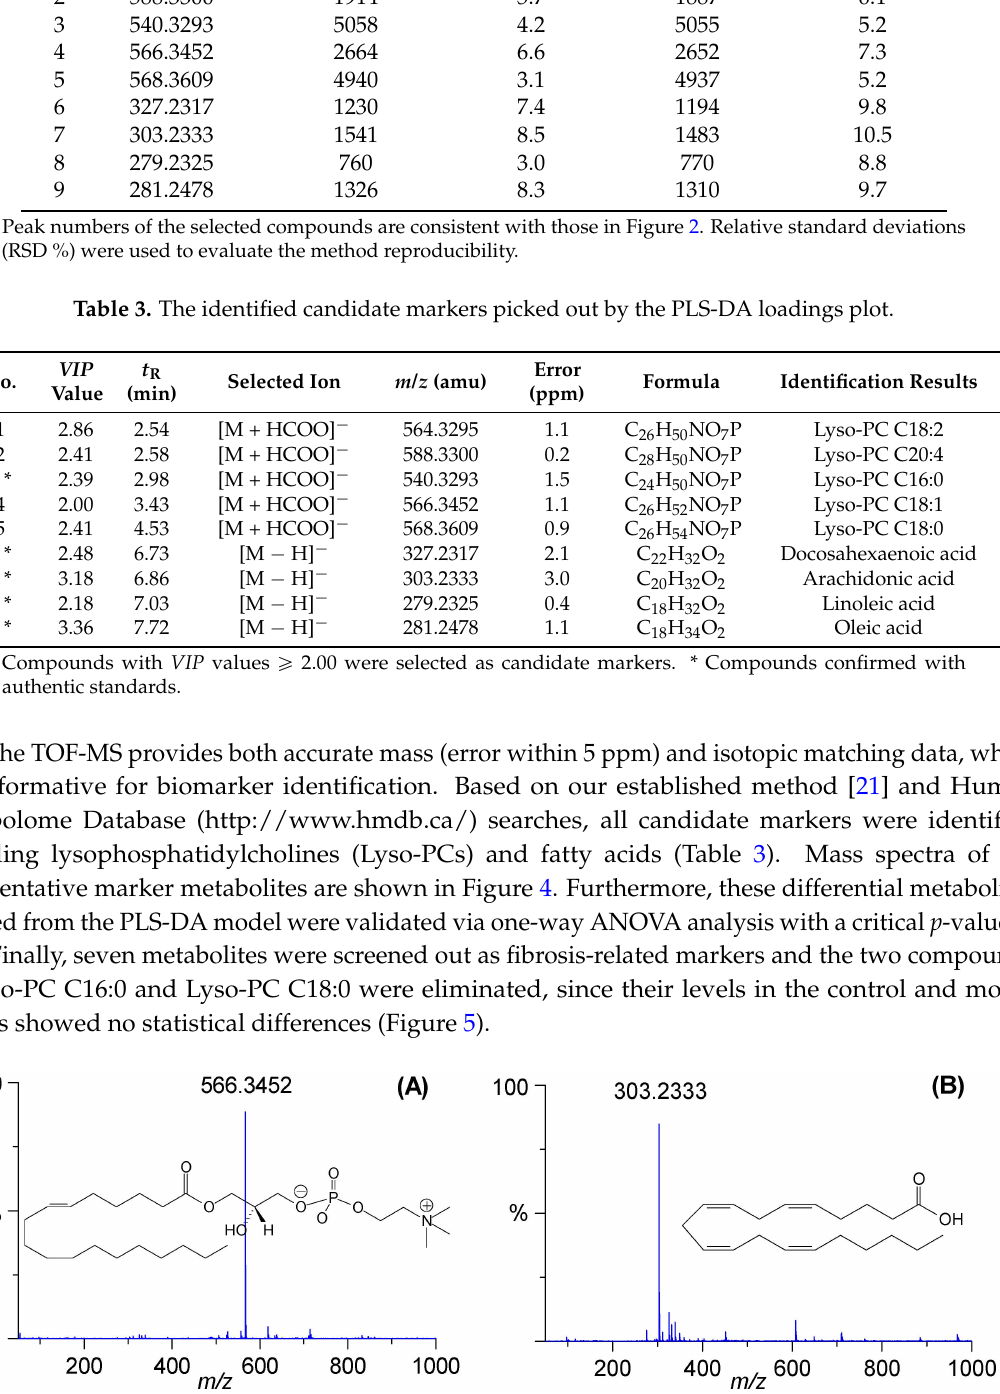
Figure 4. High-resolution TOF-MS mass spectra of the representative markers: ( A ) Lyso-PC C18:1 (No. 4) and ( B ) arachidonic acid (No. 7). The numbers of metabolites are consistent with those